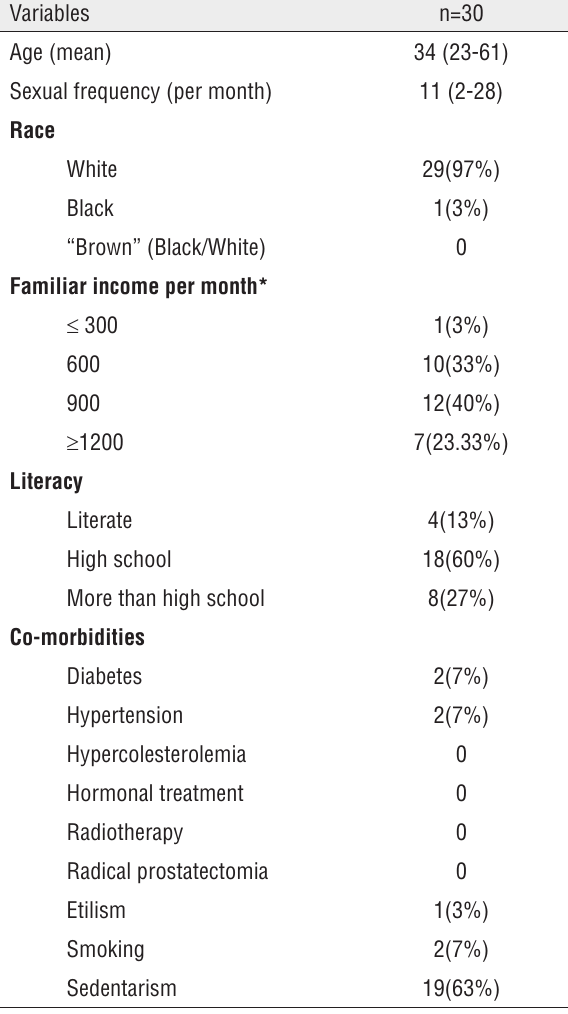
Table 2 - Caracteristics of patients without erectile